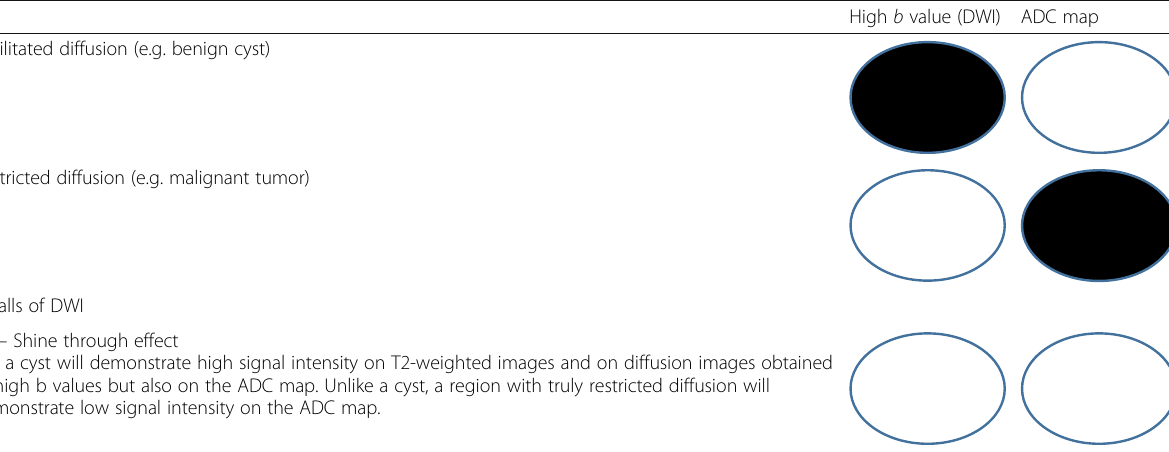
High b value (DWI) ADC map